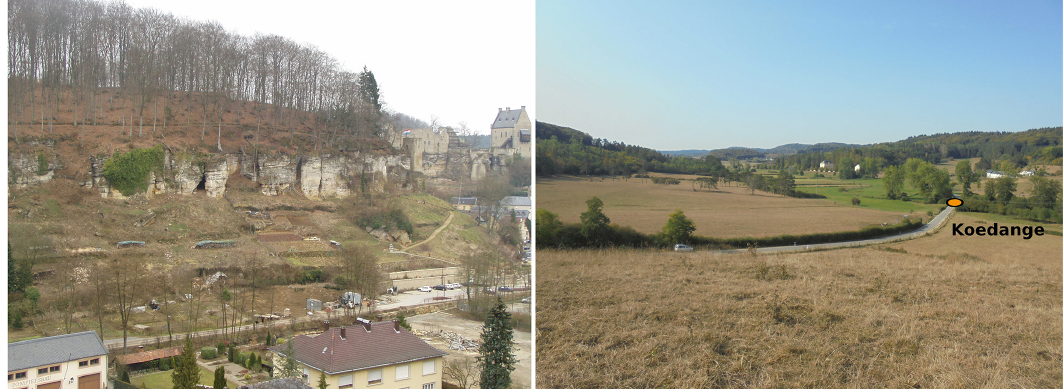
Figure 2. Overview of the Ernz Blanche catchment. Left: view of the sandstone cliffs in the White Ernz valley at Larochette (Kausch and Maquil, 2018). Right: view the upstream part of the Koedange station (marked in orange). The arable land roughly corresponds to the Km3 geology, while the surrounding forest corresponds to the Li2 geology.